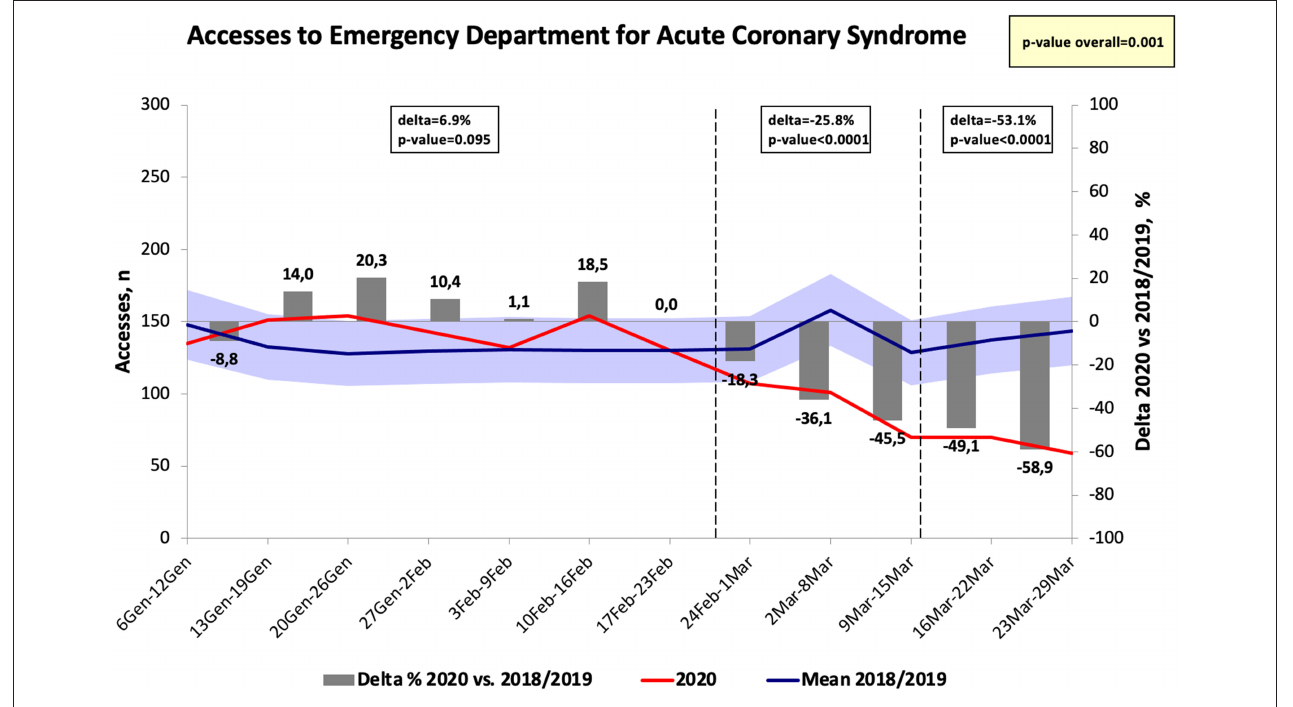
FIGURE 6 | Number of accesses to emergency department for heart failure in